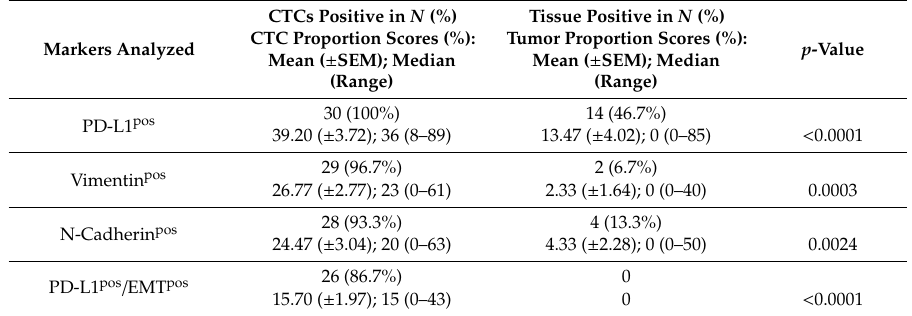
Table 2. Expression proportion scores of patient-matched CTCs and NSCLC tumor tissues ( N =